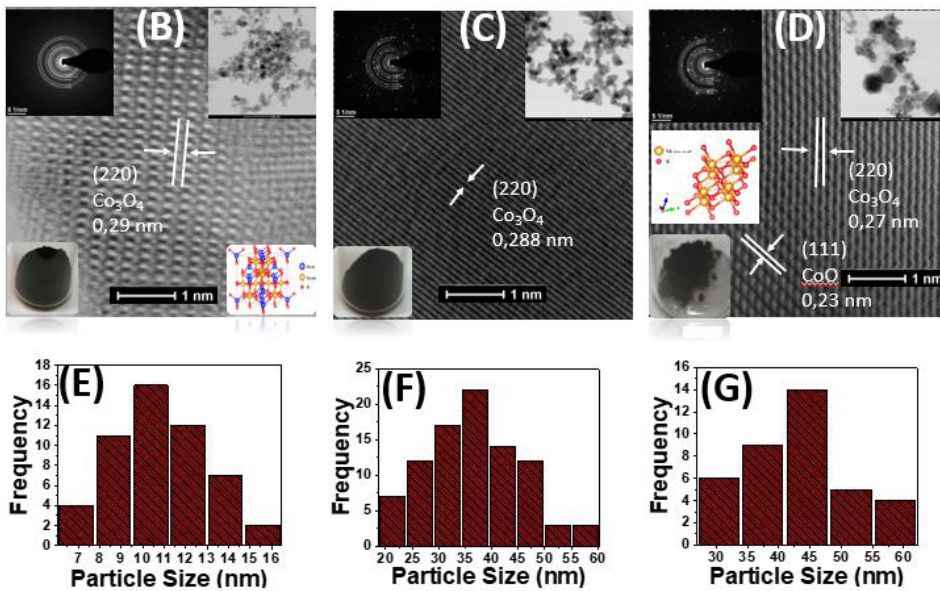
Figure 1. TEM images and ( A ) XRD pattern of our #Co1, #Co2 and #Co3 nanomaterials. ( B ) As prepared Co 3 O 4 , #Co1, ( C ) Calcined Co 3 O 4 , #Co2 and ( D ) CoO@Co 3 O 4 particles #Co3. Insets: SAED pattern of #Co1, #Co2 #Co3 respectively and photos of the powders. Size pattern distribution histograms of ( E ) #Co1 ( F ) #Co2 ( G ) #Co3.